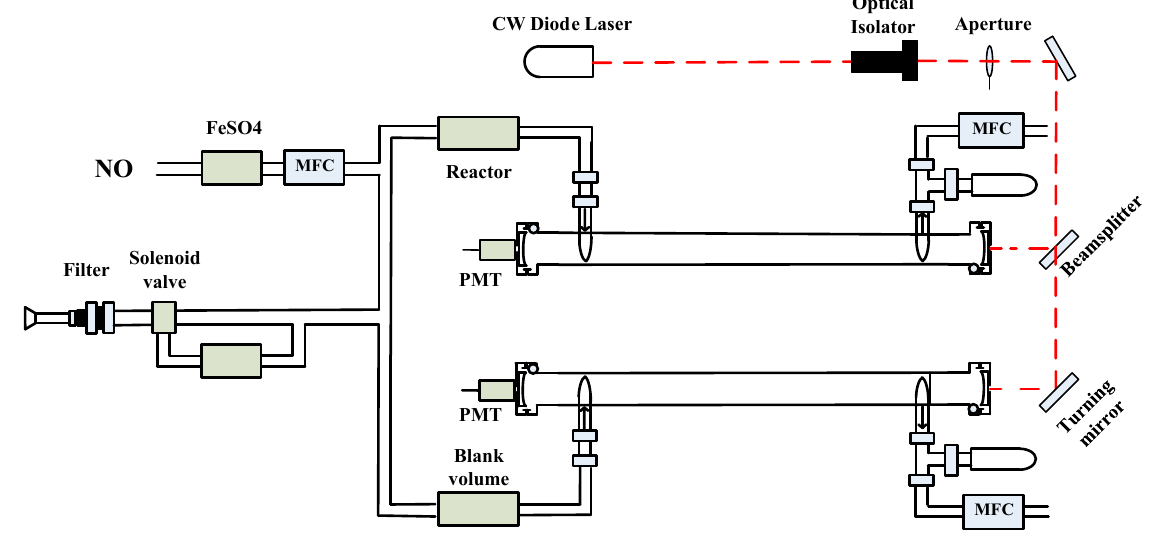
Figure 1. Schematic diagram of the CRDS − O x /NO 2